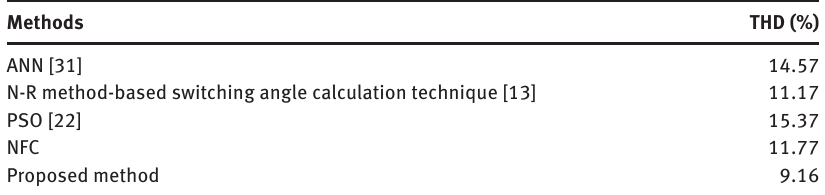
Table 3: Comparison of THD using Different